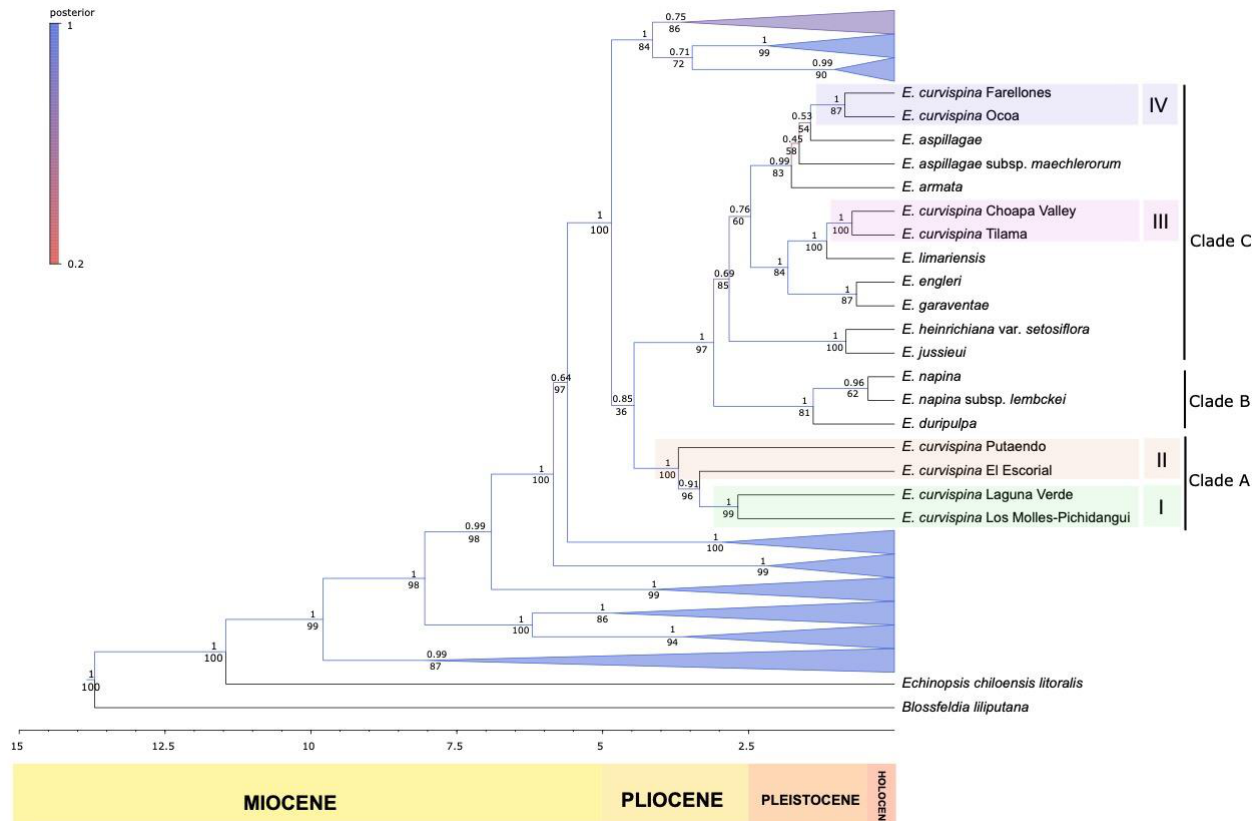
Figure 2. Time-calibrated phylogeny of Eriosyce with internal clades collapsed, except for the Hor- ridocactus clade, to facilitate visualization of the phylogenetic position of the putative members of E. curvispina . Bayesian posterior probabilities are shown above branches, and maximum-likelihood bootstrap support values are shown below branches. Groups I to IV are based on the sequence-based phylogenetic inferences with five molecular markers (Section 2.2).